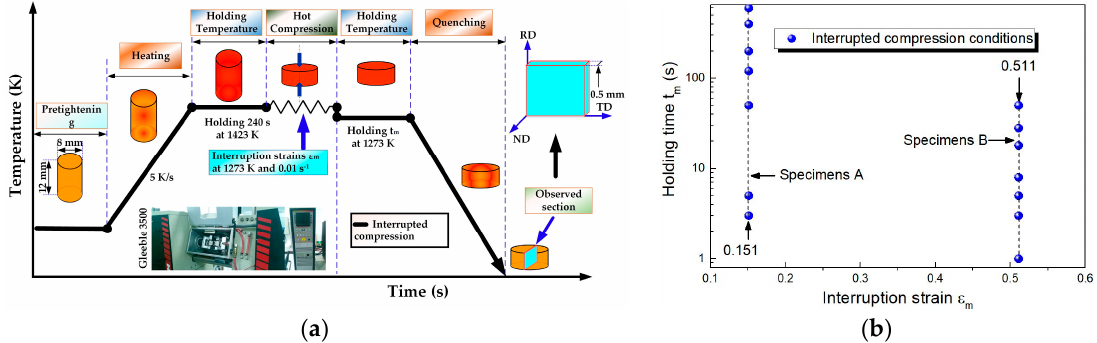
Figure 1. Detailed experimental design: ( a ) description of compression experimental procedure; ( b ) interrupted compression conditions.